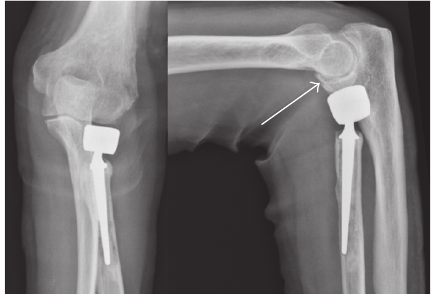
Figure 2: Surgery was indicated for both painful loosening of a radial head prosthesis and an osteochondral fracture of the capitulum humeri (white arrow).